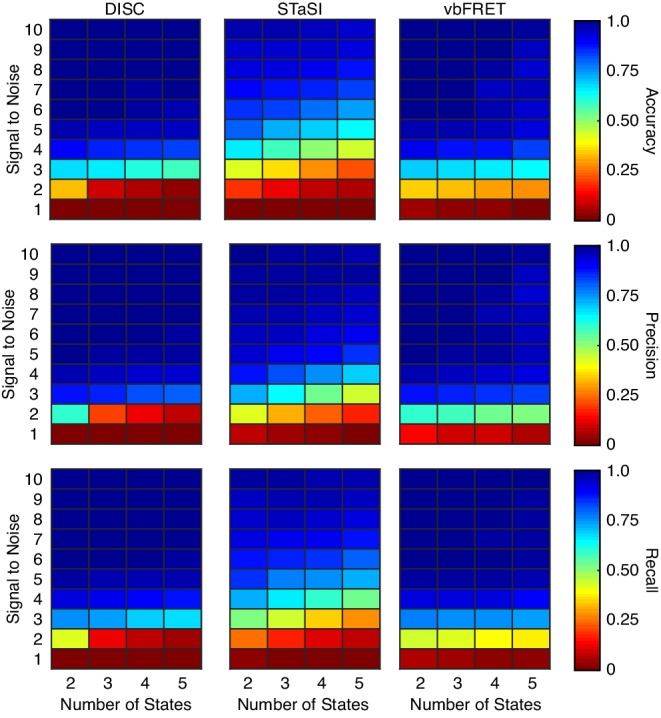
Algorithm performance on simulations without heterogenous fcAMP emission.Recreation of simulations from Figure 3 of the main text without the inclusion of heterogenous intensities per binding event. Each value is the average accuracy (top), precision (middle), and recall (bottom) across 100 trajectories 200-second-long trajectories collected at 10 Hz at the indicated SNR and number of states (Materials and methods).